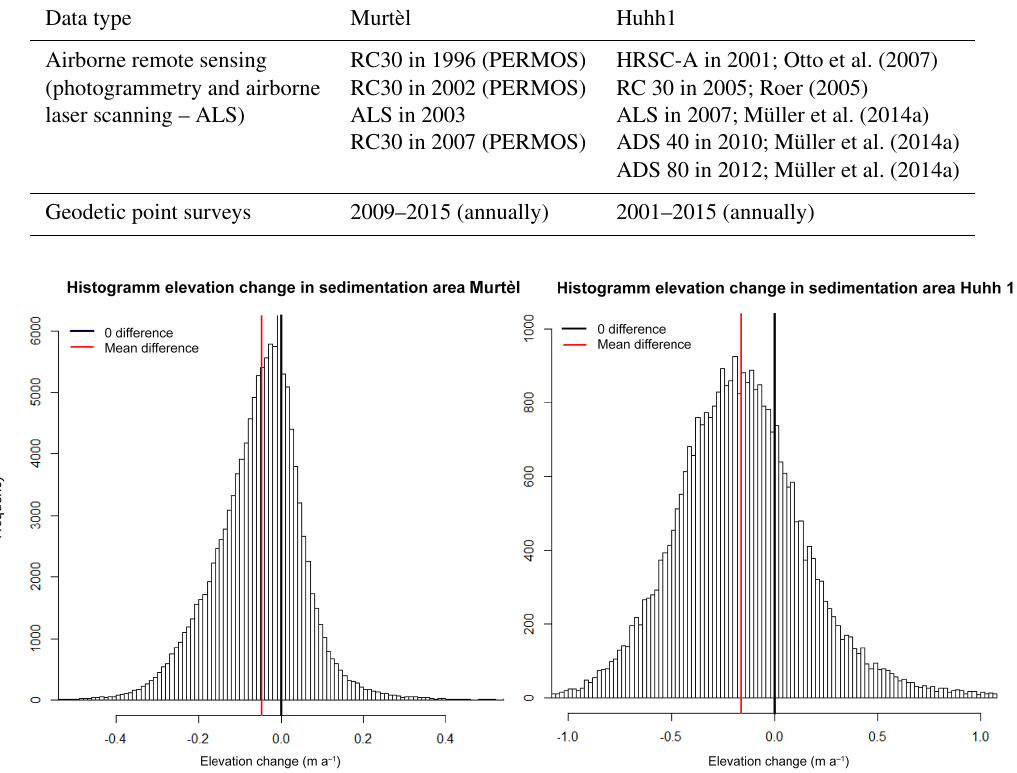
Figure 3. The frequency distribution of annual vertical surface change (ma − 1 ) from DEM differencing in the talus slope–sedimentation area of the two rock glacier systems. Both systems show negative mean values (red lines). The black line refers to 0ma − 1